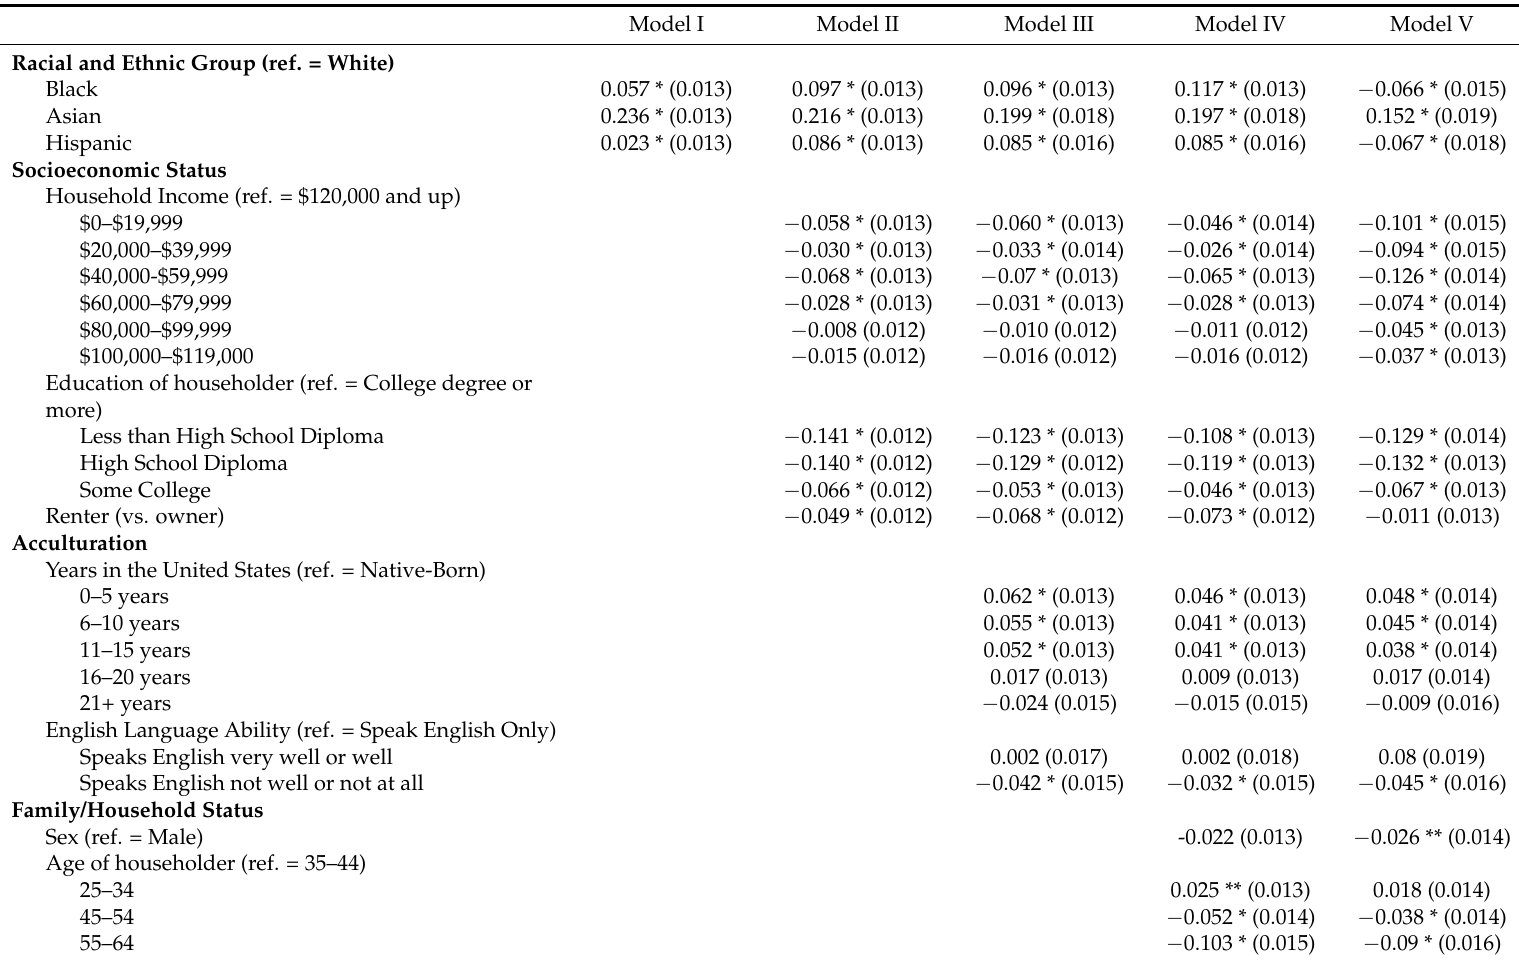
Table A1. Pooled Binary Logisitic Regression Results Predicting Developing (vs. Mature) Suburban Outcomes-Standardized Coefficients (Standrd Errors). Model I Model II Model III Model IV Model V Racial and Ethnic Group (ref. = White) Black